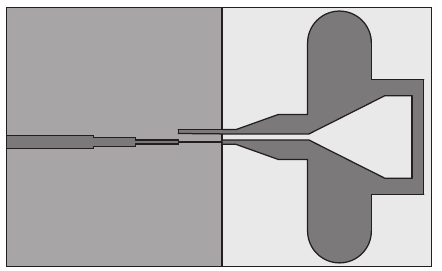
Figure 31: A UWB dipole antenna with semi-elliptical-ended arms and shorting bridge [98]. Dark gray upper metal face, medium gray bottom metal face, and light gray dielectric